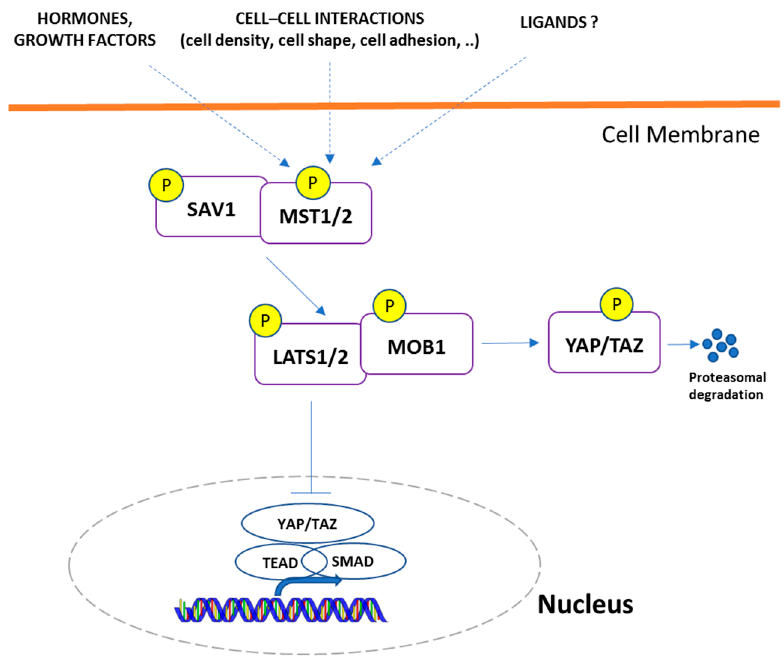
Figure 2. Hippo–YAP pathway. When the Hippo pathway is activated, MST1/2 kinases and SAV1 form a complex to phosphorylate and activate LATS1/2 and MOB1. Activated LATS1/2 phosphorylates YAP/TAZ, that is sequestered in the cytoplasm or degraded. Dephosphorylation of YAP/TAZ allows its traslocation into the nucleus and the interaction with TEAD1-4 to induce the expression of genes promoting tumor progression. MST, mammalian Ste2-like kinases Hpo orthologs; SAV, Protein Salvador Homolog 1; LATS, Large Tumor Suppressor Kinase Wts orthologs; MOB1, Mob-as-tumor-suppressor homologs; YAP, Yes Associated Protein Yki ortholog; TEAD, transcriptional enhancer associate domain; TAZ, transcriptional co-activator with PDZ-binding motif; SMAD, Mothers against decapentaplegic homolog.